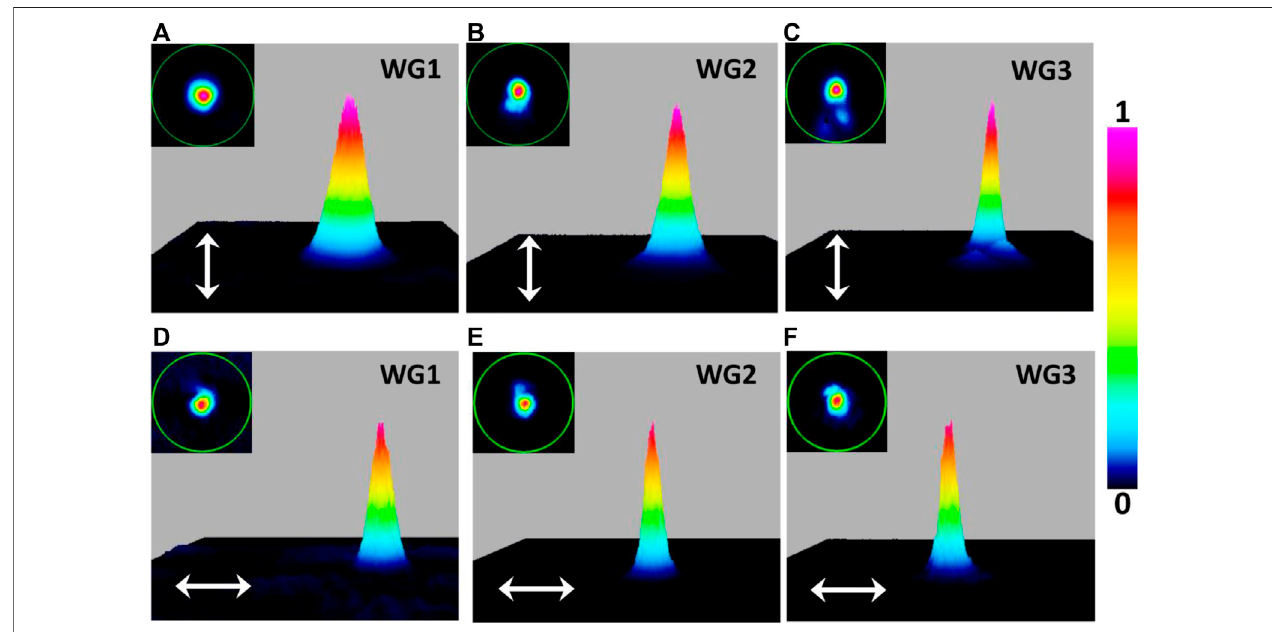
FIGURE 2 | The 2D and 3D modal pro fi les of the output light fi eld of the single-line waveguides WG1 at (A) TM polarization, (D) TE polarization, WG2 at (B) TM polarization, (E) TE polarization, and WG3 at (C) TM polarization, (F) TE polarization.